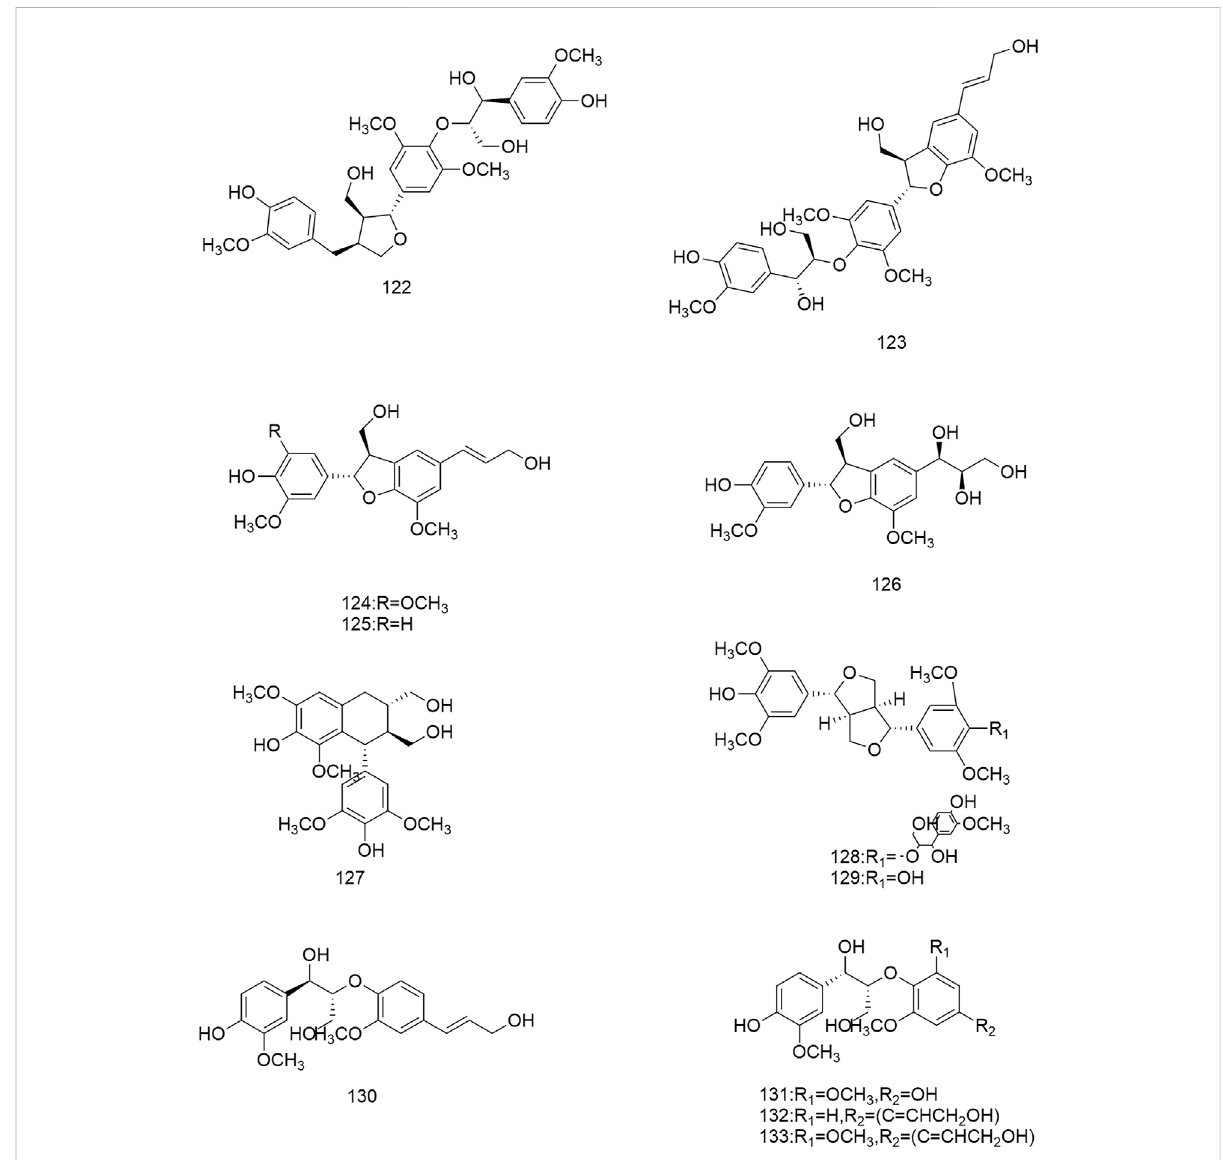
FIGURE 6 Diagrammatic representation of the structural formulas of others of compounds found in R. laevigata Michx.